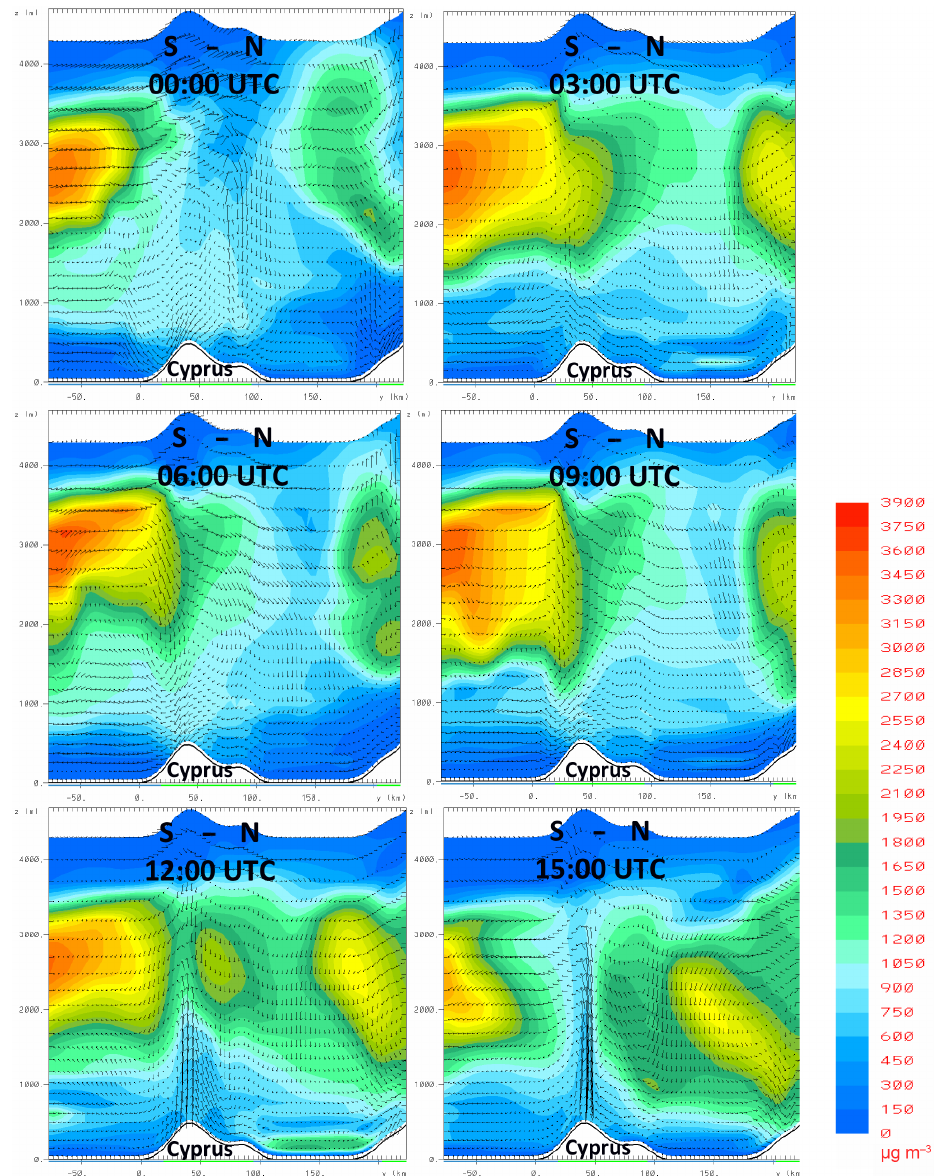
Figure 13. Vertical cross section (south–north) of modelled dust concentration over Cyprus during 00:00–15:00UTC on 8 September 2015. The location of the cross section is shown in Fig.